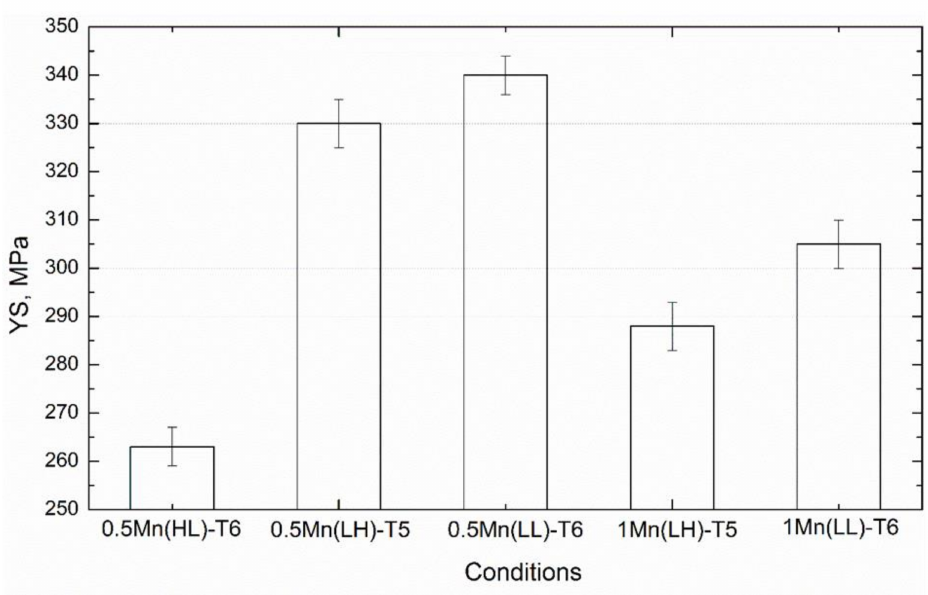
Figure 4. Room-temperature YS of the experimental alloys after aging